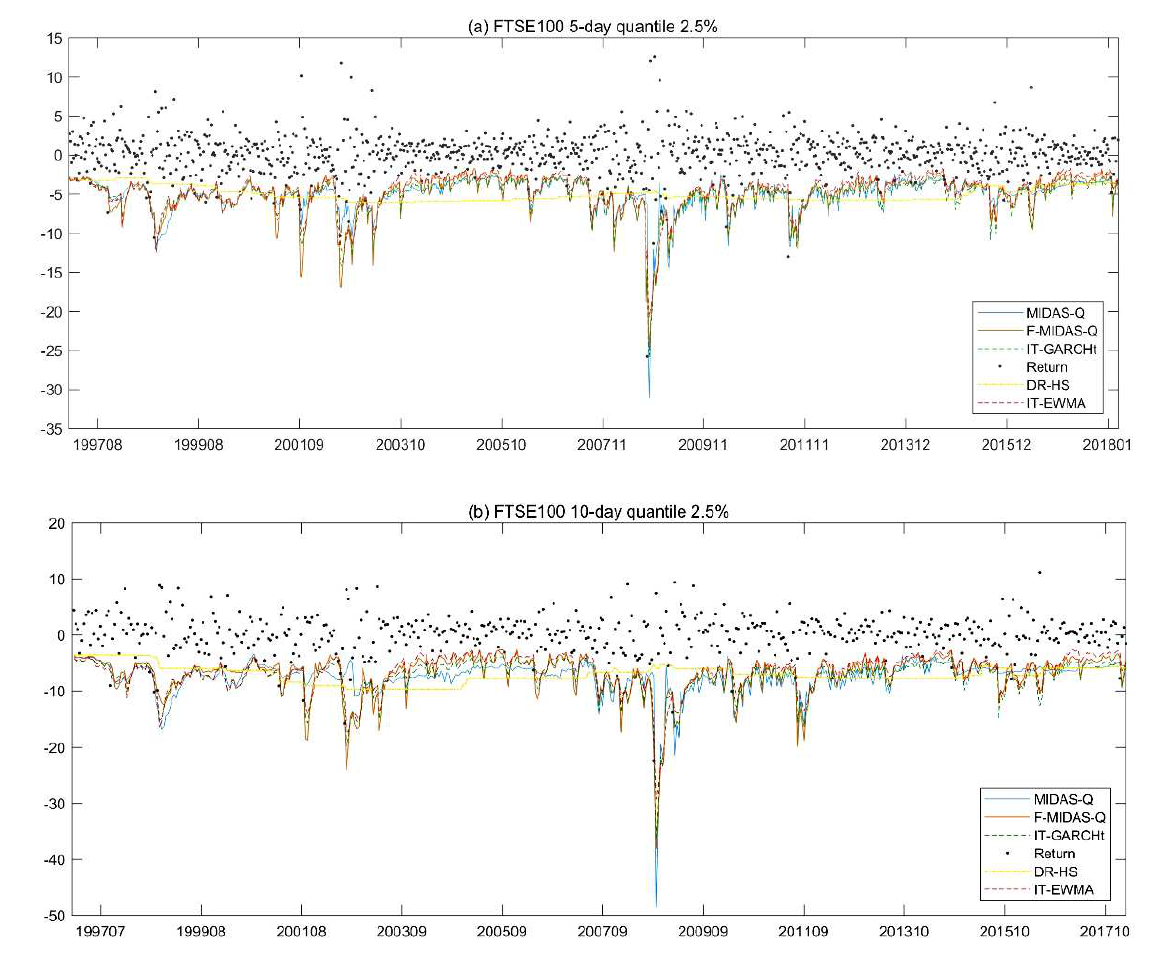
Figure 1. Out-of-sample forecasts of the 5-step and 10-step VaR for the FTSE100 index at the 2.5% risk